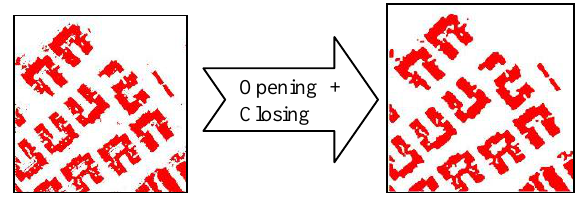
Figure 5: Roof buildings mask obtained before and after application of mathematical morphology operators.